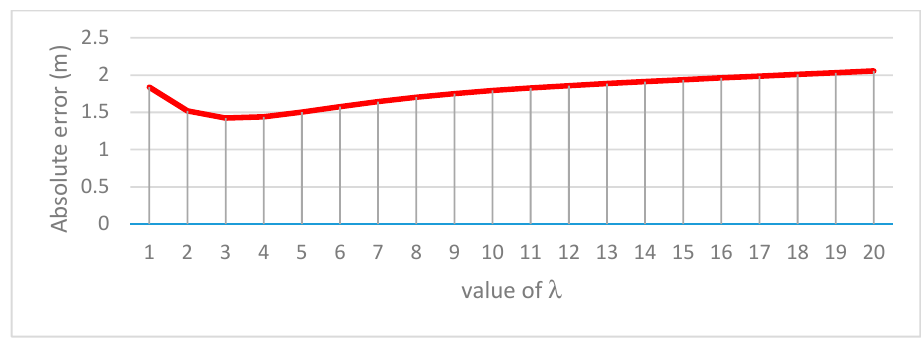
Figure 6. Sensibility analysis of parameter λ .